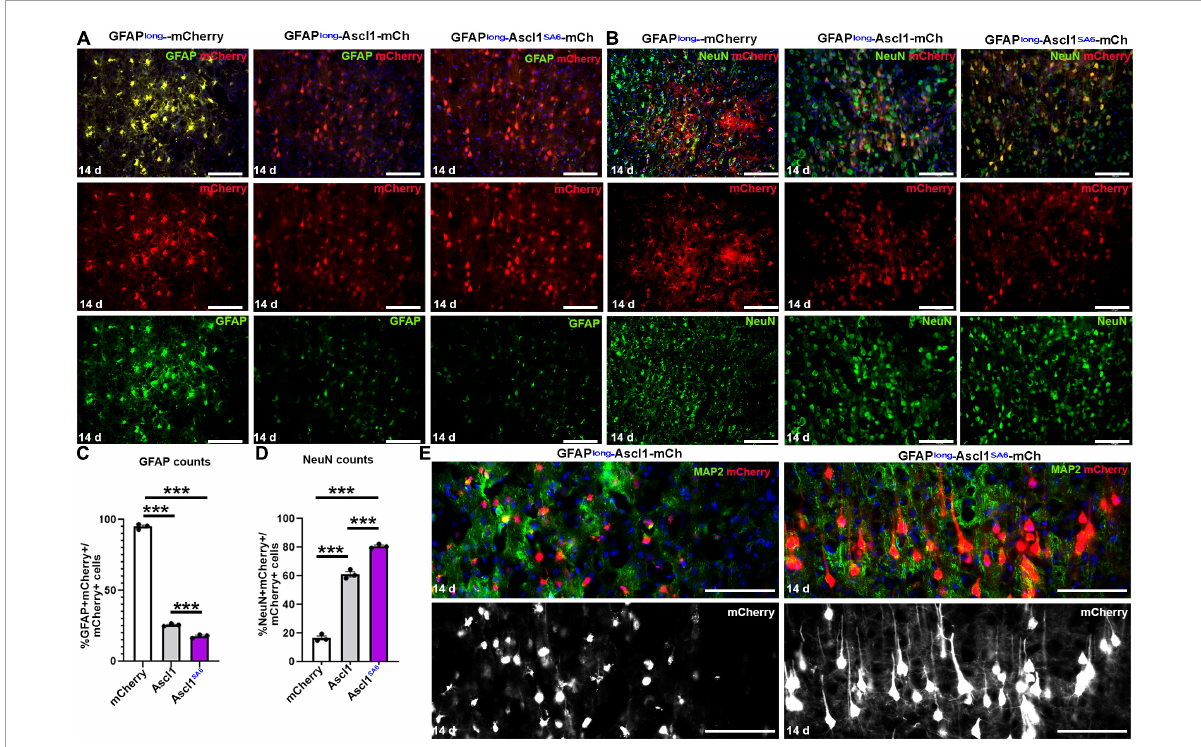
FIGURE2 Ascl1 and Ascl1 SA 6 induce neuronal marker expression when expressed in cortical astrocytes in vivo. (A,B) mCherry co-expression with GFAP (A) or NeuN (B) 14 days post-transduction of AAV8-GFAPshort-mCherry, AAV8-GFAPshort-Ascl1-mCherry, or AAV8-GFAPshort-Ascl1 SA 6 -mCherry. Blue is DAPI counterstain. (C,D) Quantification of the percentage of mCherry + transduced cells expressing GFAP (C) or NeuN (D) 14 days post-transduction. (E) High magnification images of mCherry + cells co-stained with MAP2 at 14 days post-transduction of AAV8-GFAPshort-Ascl1-mCherry, or AAV8-GFAPshort-Ascl1 SA 6 -mCherry. Blue is DAPI counterstain. Scale bars = 100 µ m. Significance was defined as p -values less than 0.05 and denoted as follows: ns, not significant, < 0.05 *, < 0.01 **, < 0.001 ***.